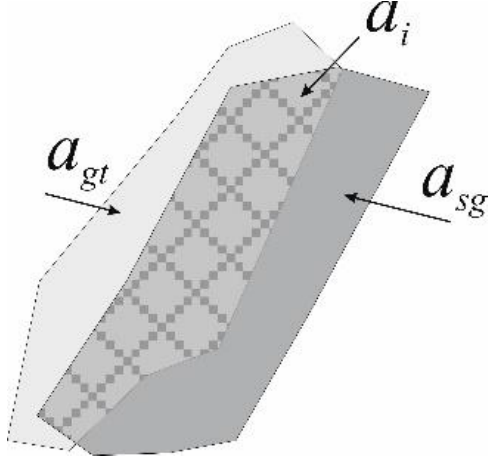
Figure 5. Illustration of the calculation of metrics. Since the output values of the neural network are in the range of [ 0; 1 ] the Dice coefficient was calculated for different thresholds. The best result was achieved for a threshold of 0.5. For the set of images under study, DSC @0.5 = 0.912 and IoU@0.5 = 0.894. These results are comparable with the indicators achieved by other authors in similar areas (see Table 1) and meet the industry requirements. Table 1. Results of comparing the developed model with similar models for detecting surface dam- age.